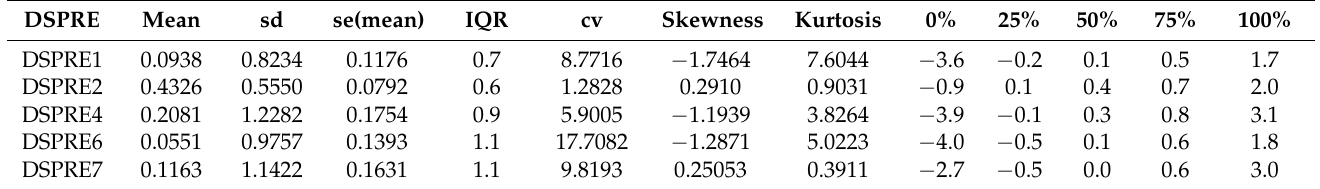
Figure 6. Bland Altman plot, for the sole of the index 1, right foot before the walk, comparing the two measurements: the sample data given by the survey and the model only considering the variables that influence (see Table 1). Table 2. Difference between the indices on the two sole (left and right) for nondiabetic people before the walk in the regions 1, 2, 4, 6 and 7 (see Figure 1). Here we can see the most important statistic of then like mean, the standard deviation (sd), the standard error of the mean (sem), interquartile range (IQR), the coefficient of variation (cv), the degree of distortion from the symmetrical bell curve or the normal distribution or the measure of symmetry (Skewness), the measure of whether the data are heavy-tailed or light-tailed relative to a normal distribution (Kurtosis), and the